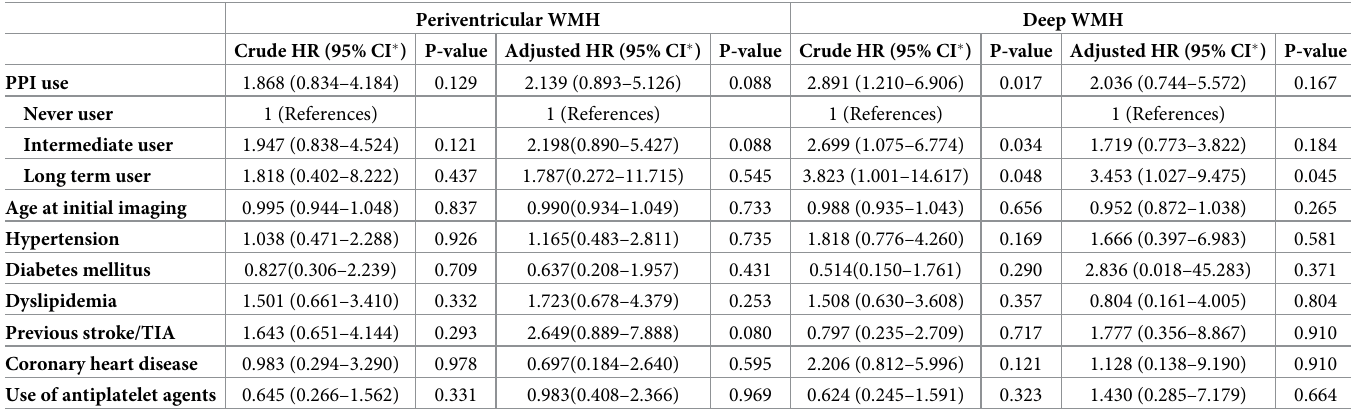
Table 2. Factors associated with the progression of Fazekas score of white matter